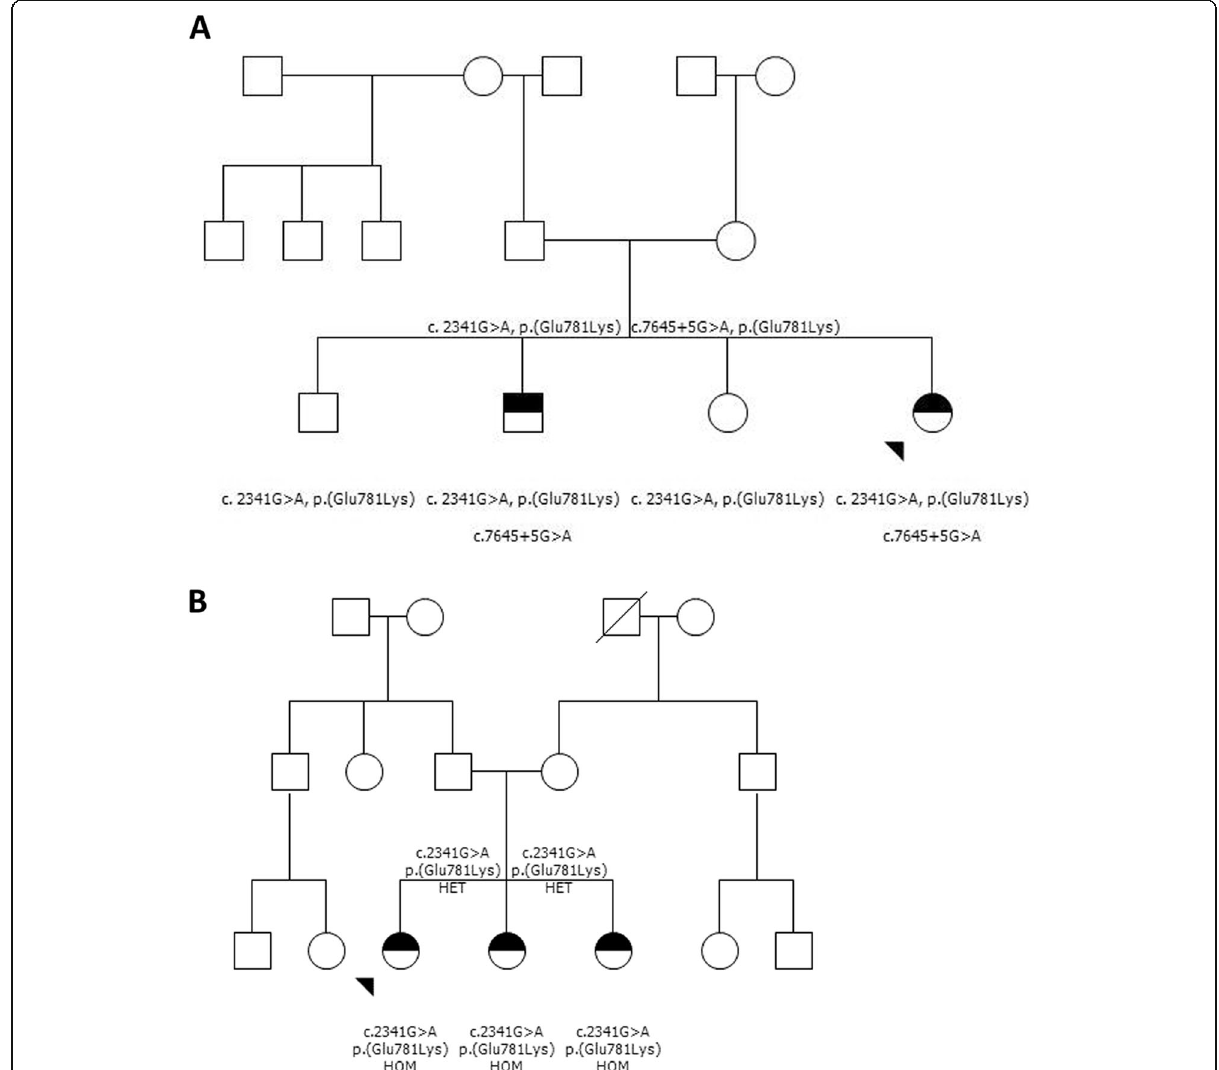
Fig. 1 a Pedigree of family 1 with one female and one male offspring affected. Two novel mutations were detected in the DNAH11 gene: c.2341G > A p. (Glu781Lys) ja c.7645 + 5G > A, demonstrating compound heterozygosity. b : Pedigree of family 2. All three children (female) were affected. The novel mutation c.2341G > A p. Glu781Lys was first detected in family 1. HET = heterozygous DNAH11 gene mutation. HOM